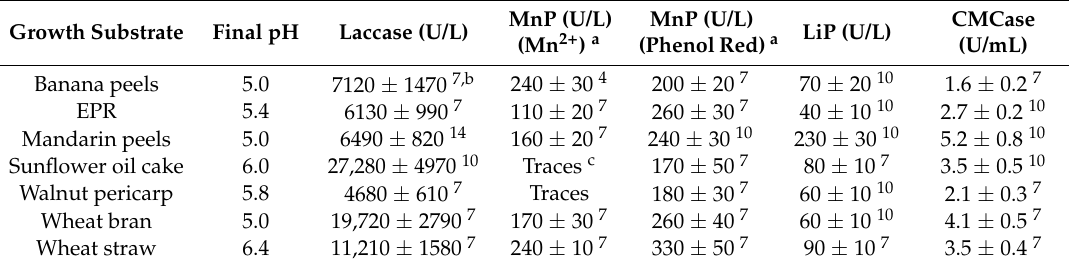
Table 3. The effect of lignocellulosic growth substrates on the C. gallica LME and endoglucanase activity. The fungus cultivation was performed in the nutrient medium containing 10 g/L glycerol and 20 g/L lignocellulosic materials as a carbon source; no inducer was added. Growth Substrate Final pH Laccase